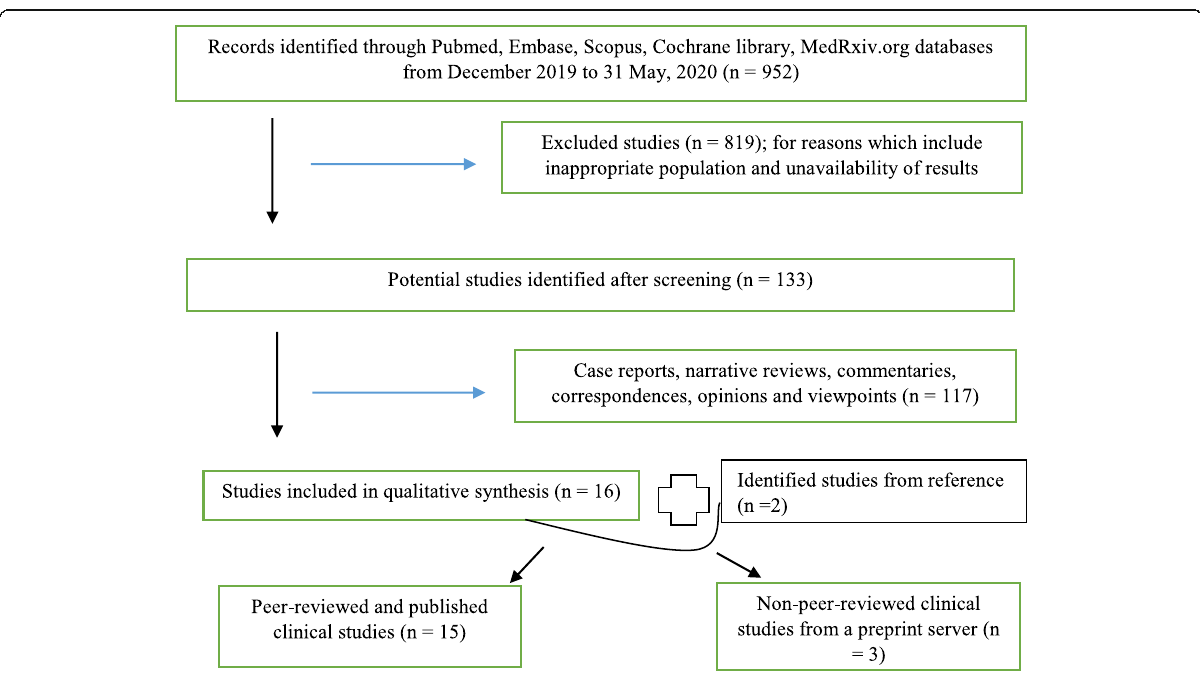
Fig. 2 Flowchart showing steps in the qualitative synthesis of evidence from